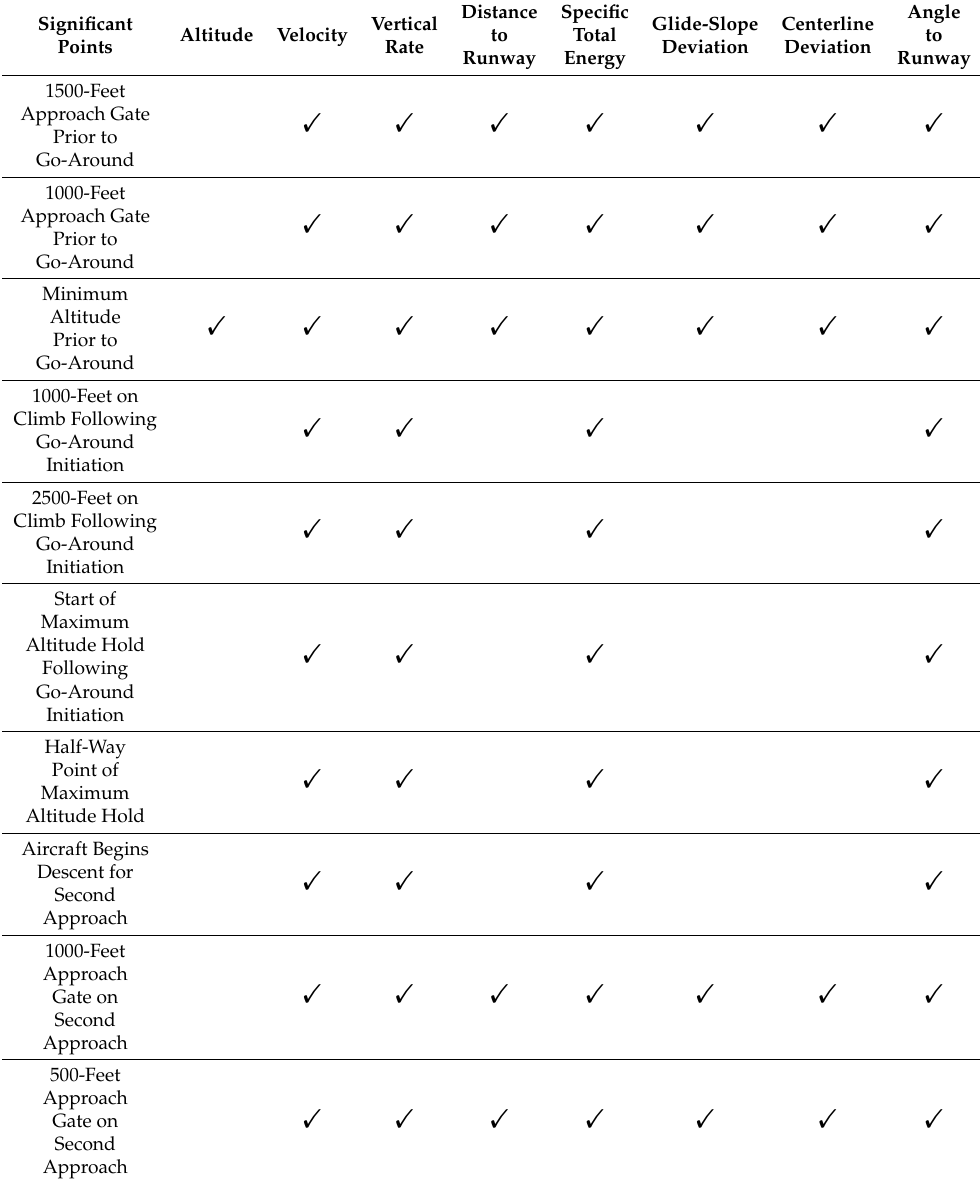
Table 1. Summary of the significant points and features selected. Significant Points